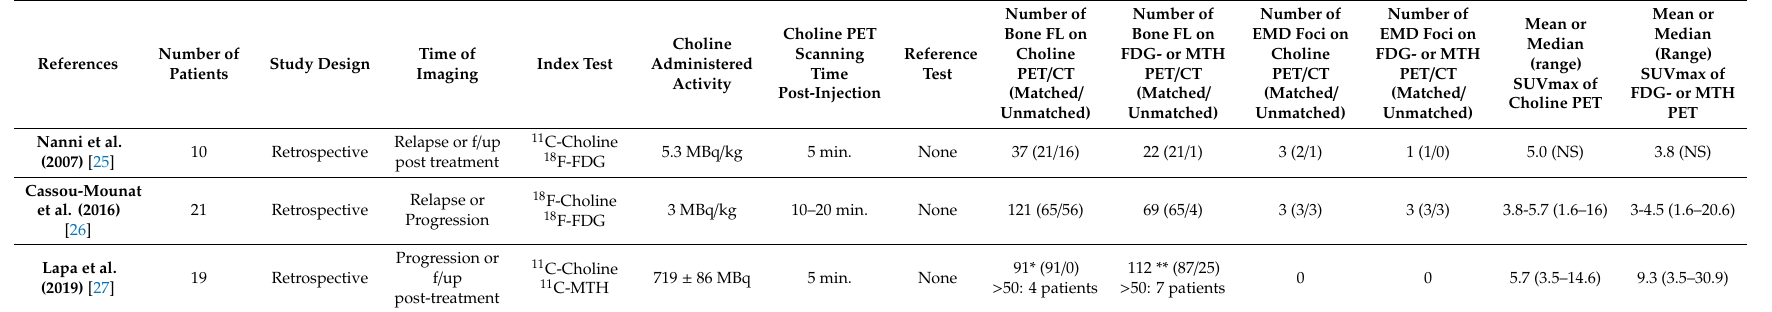
Table 1. Characteristics and main results of studies exploring the use of 11 C-Choline or 18 F-Choline in multiple